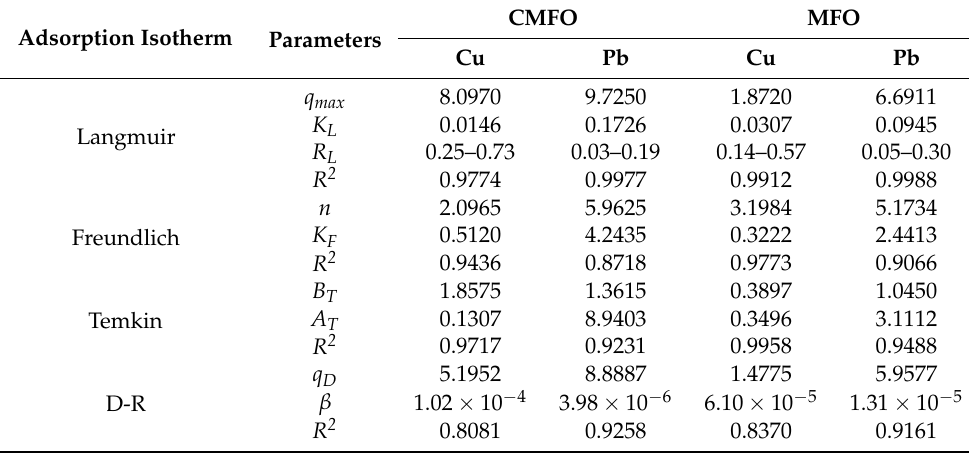
Table 3. Isotherm model parameters for the uptake of Cu(II) or Pb(II) by CMFO or MFO. Adsorption